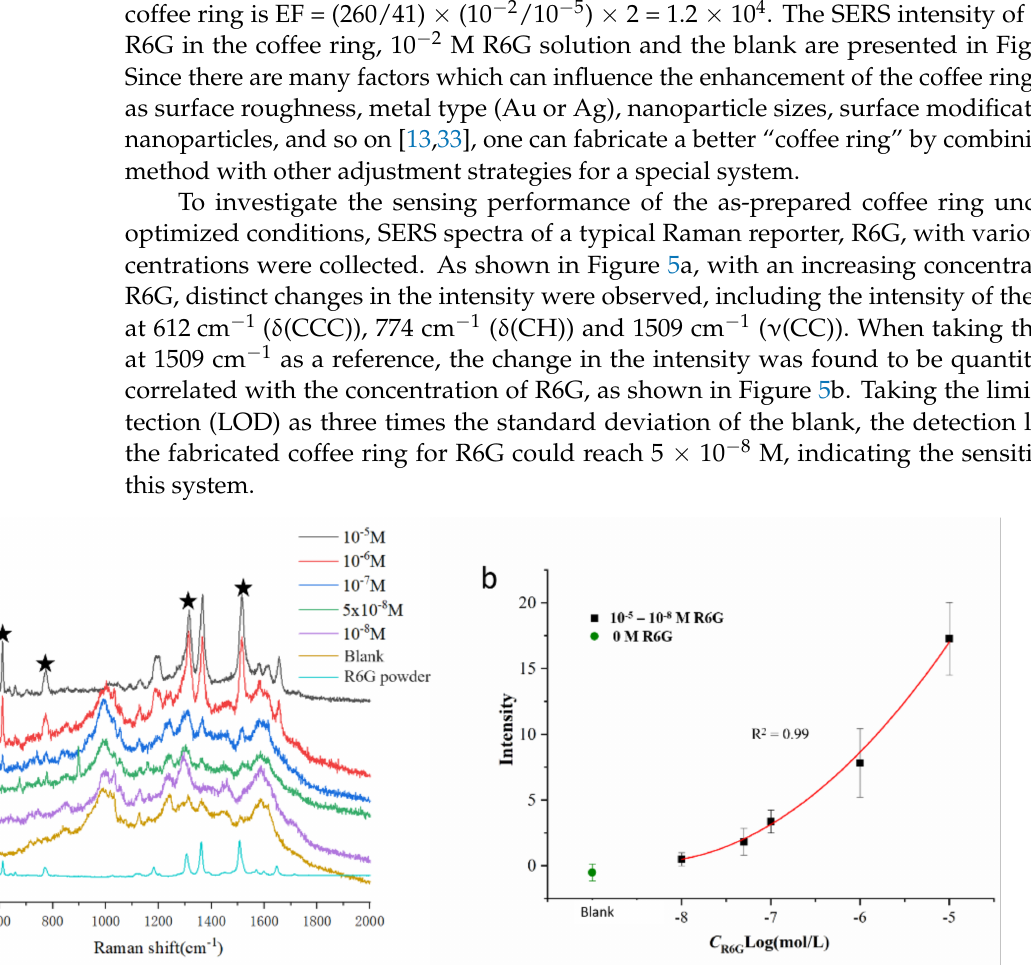
Figure 5. ( a ) Raman spectra of R6G with different concentrations in the optimized coffee ring substrate. The stars indicate the main fingerprint peaks of R6G in the coffee ring. ( b ) Semilog plot of the peak intensity as a function of R6G concentration for the peak of 1509 cm − 1